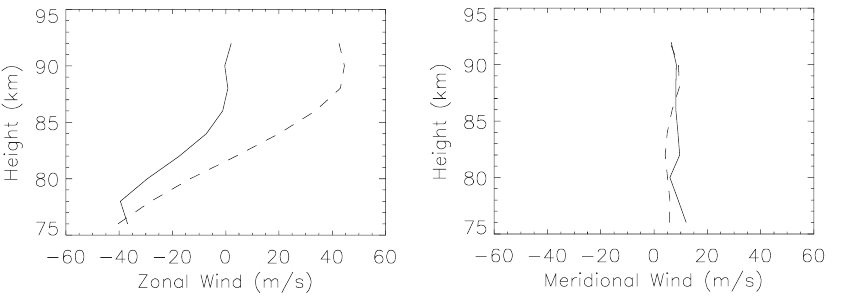
Fig. 10. Thirty six day averages of HRDI (dashed) and Birdlings Flat radar (solid) winds from early